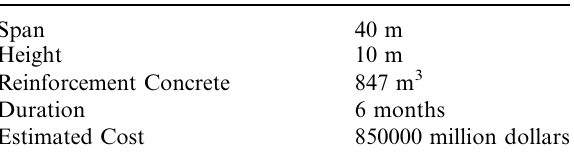
Table 2. Bridge specifications